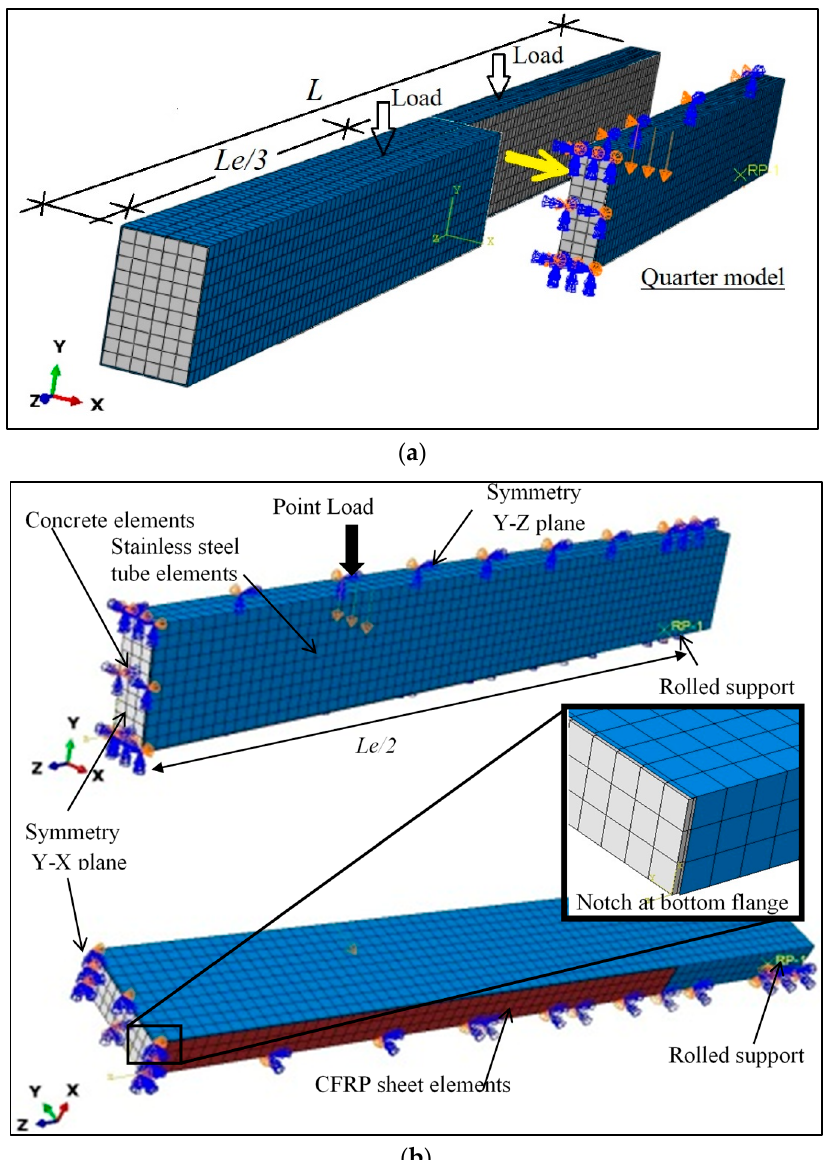
Figure 15. Typical 3D RCFSST model strengthened with CFRP sheets. ( a ) Full model and ( b ) quar- ter